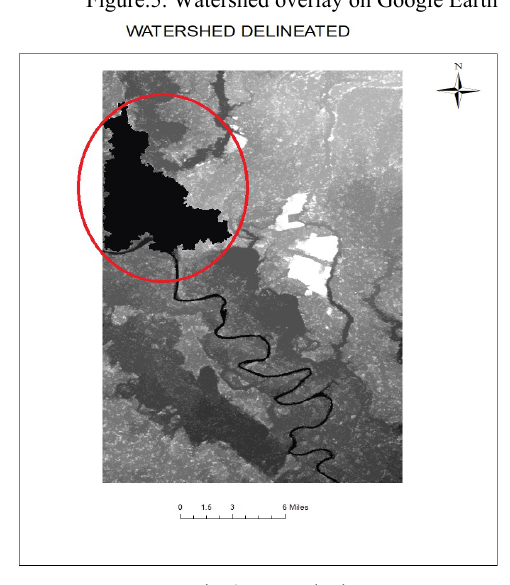
Figure. 3. Contour Map